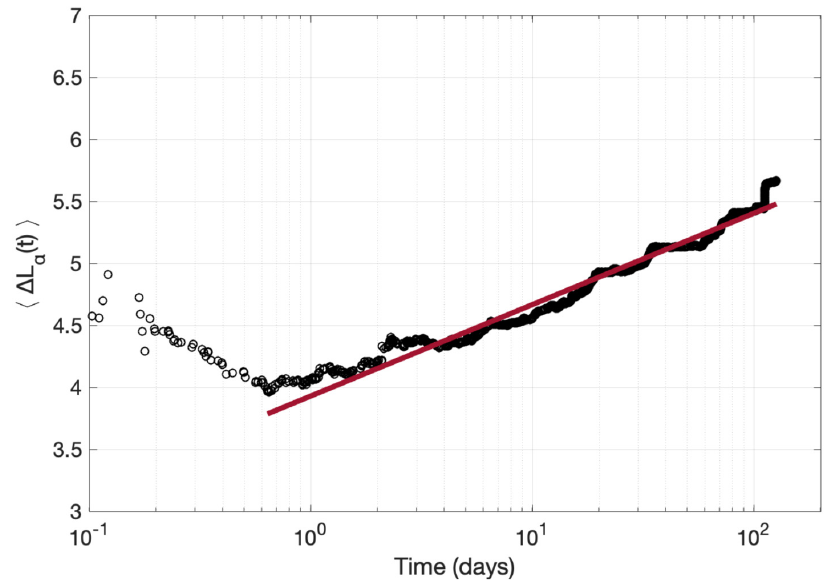
Figure 18. The average expansion (in km) of the aftershock zone as function of the logarithm of time (symbols) for Central Crete 2022, Mw6.0 aftershock sequence. The solid line represents the logarithmic growth of the aftershocks